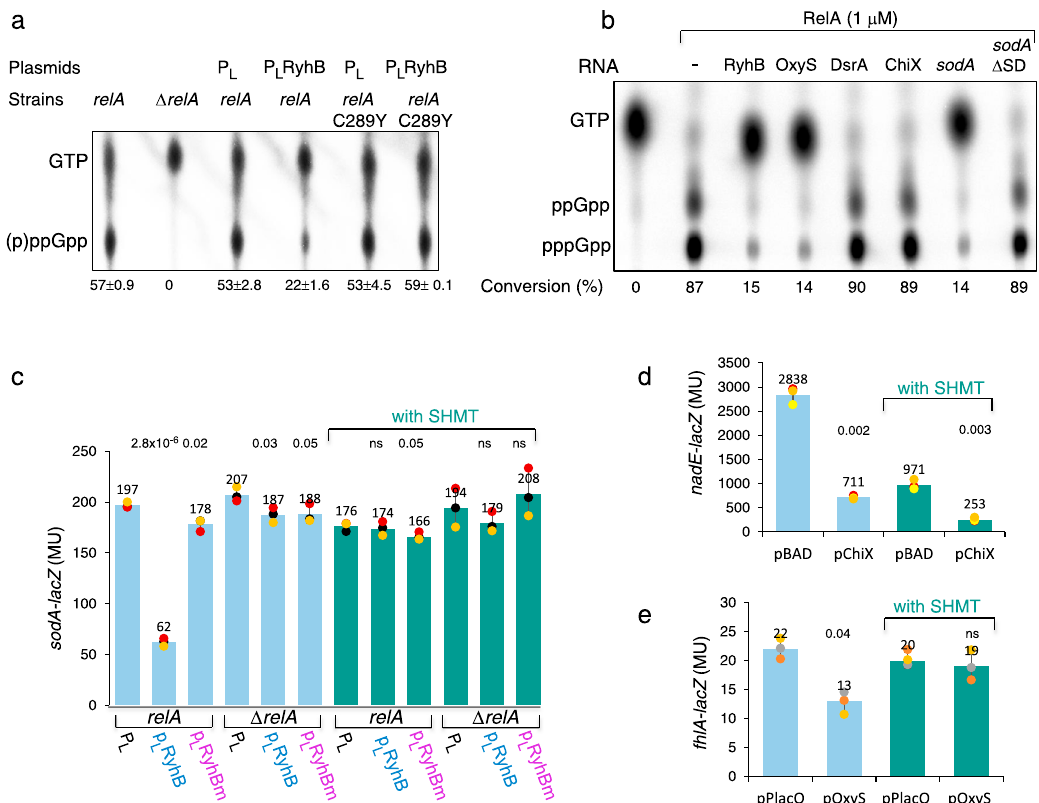
Fig. 6 (p)ppGpp production and RNA binding are two mutually exclusive functions of the stringent response regulator RelA. a In vivo (p)ppGpp production is inhibited by RyhB. E. coli strains; relA + , Δ relA , and rel: C289Y (chromosomally encoded) carrying plasmids as indicated were assayed for (p) ppGpp production as described in “ Material and methods ” . The intensity of the spots was determined by the ImageLab program and percentage of (p) ppGpp production of the total was calculated (% conversion). Mean and SD of two biological samples are presented. b In vitro (p)ppGpp production is inhibited by speci fi c RNAs. Puri fi ed RelA was incubated with 50 nM of either RyhB, OxyS, DsrA, ChiX, sodA , or sodA - Δ SD and assayed by TLC. The intensity of the spots was determined by the ImageLab program and percentage of (p)ppGpp production of the total was calculated (% conversion). DsrA and ChiX lack a GGAGA site (see Fig. S5). c – e RelA mediated basepairing regulation under normal growth conditions and in response to amino acid starvation by serine hydroxamate (with SHMT). β -galactosidase assays of target gene fusions in the presence of their corresponding sRNAs (RyhB/ sodA , ChiX/ nadE , or OxyS/ fhlA ). ChiX expression was induced by 0.2% arabinose from the BAD promoter. Constitutive expression of plasmid encoded RyhB and OxyS in Δ ryhB and wild type, respectively. n = 3 biologically independent experiments. Data are presented as mean values ± SD. Two-tailed unpaired t -test were performed; the absolute p values are indicated. Source data provided as a source data fi